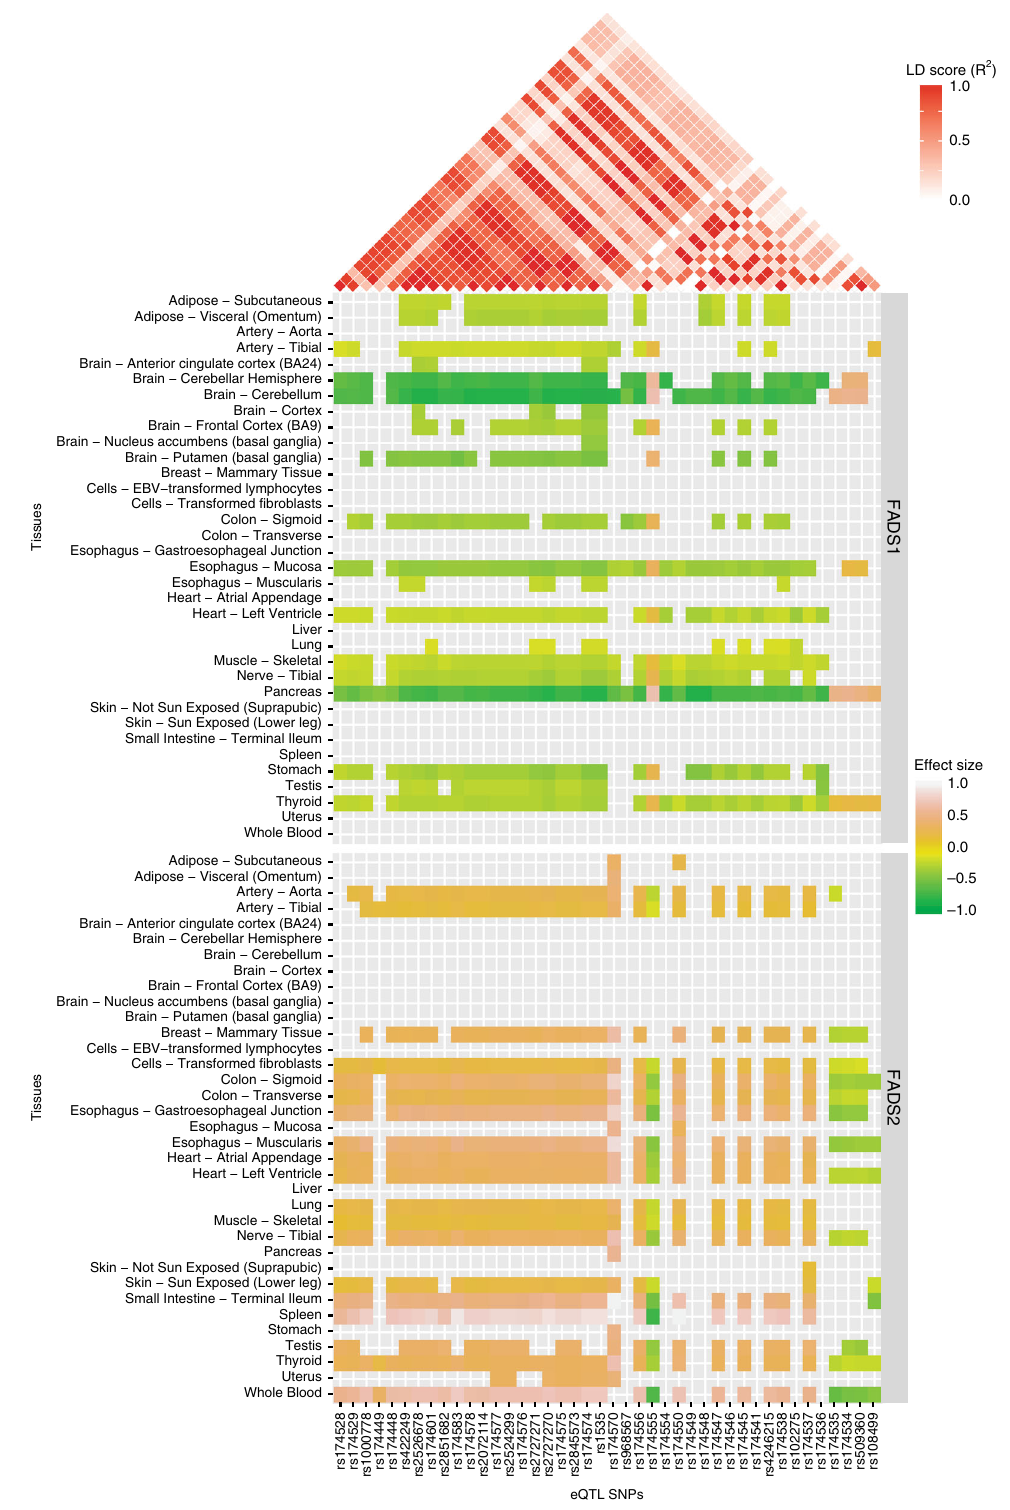
Fig. 4 eQTLs have different effect patterns within the fat metabolism cluster. Spatial eQTLs have tissue-speci fi c and LD-dependent effects on genes in the FADS cluster. There is also an inverse association between the eQTL effects on FADS1 and FADS2 . rs174574, rs422249, rs174448, rs174449, and rs100078 are associated with an increase in FADS1 and decrease in FADS2 transcript levels. All other eQTLs are associated with a decrease in FADS1 and increase in FADS2 transcript levels. Effect sizes of spatial eQTL on eGenes were obtained from GTEx